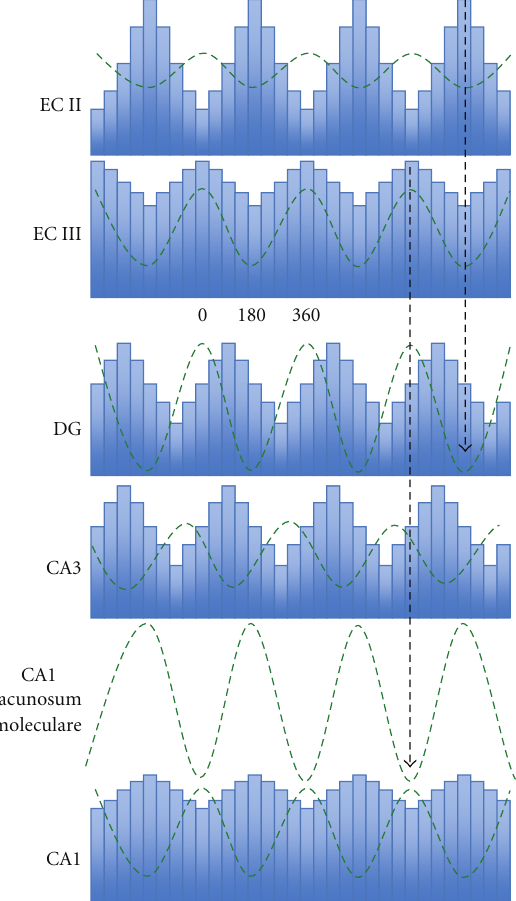
Figure 1: Schematic firing rate modulation in hippocampal and parahippocampal regions. The firing phase of principal cells is indi- cated by the histograms, while the curves describe LFP amplitudes at di ff erent locations (see text). Redrawn from